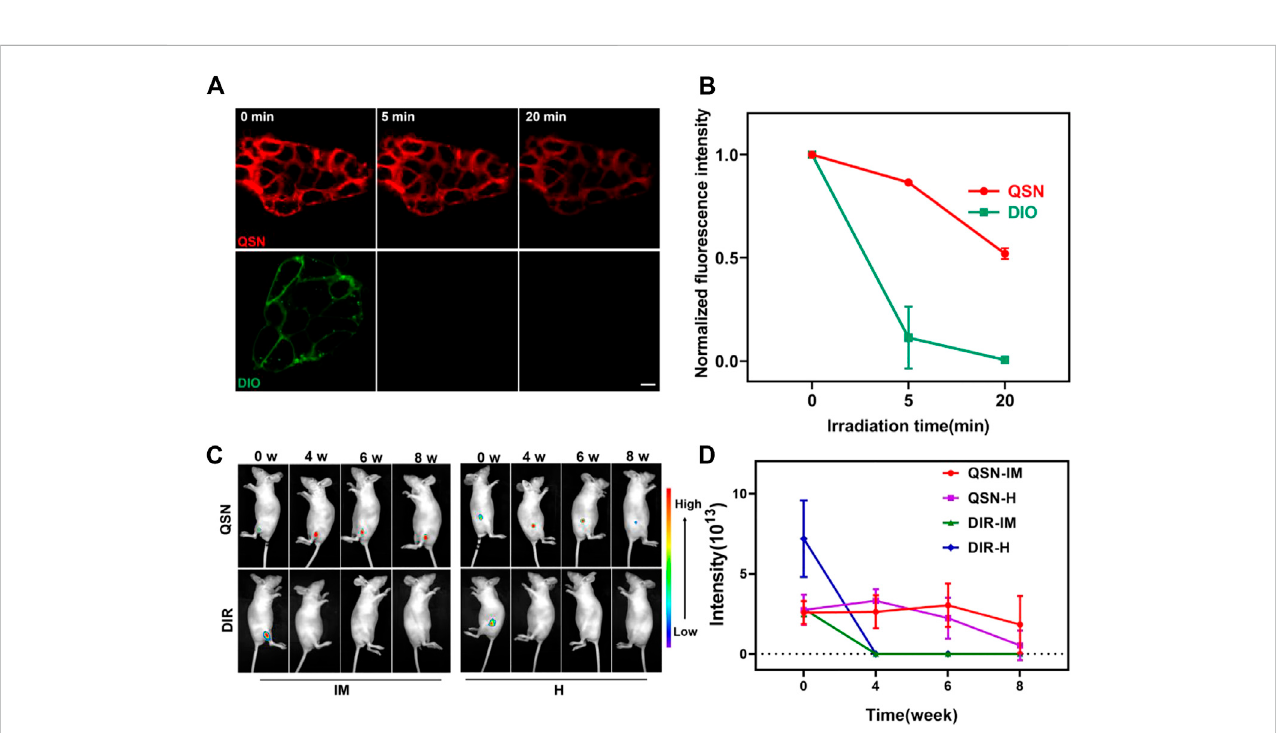
FIGURE 3 (A,B) Comparison of photostability of QSN (upper) and DiO (below) when incubating the samples with H7 and exposing to laser irradiation for 20 min, respectively. Scalebar:10 µm. (C,D) Long-term invivo imagingoftime-dependent whole-body imagingofH7NSC-bearingnudemice ( n = 3)after treatment with QSN (300 μ M) and DiR (1:2500) via intramuscular (IM) injection and hypodermic (H)